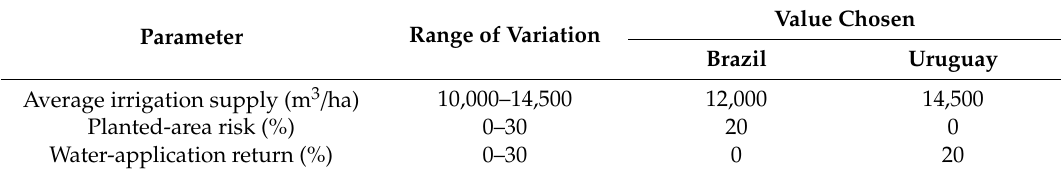
Table 5. Parameters used for the calibration of the water-management model. Parameter